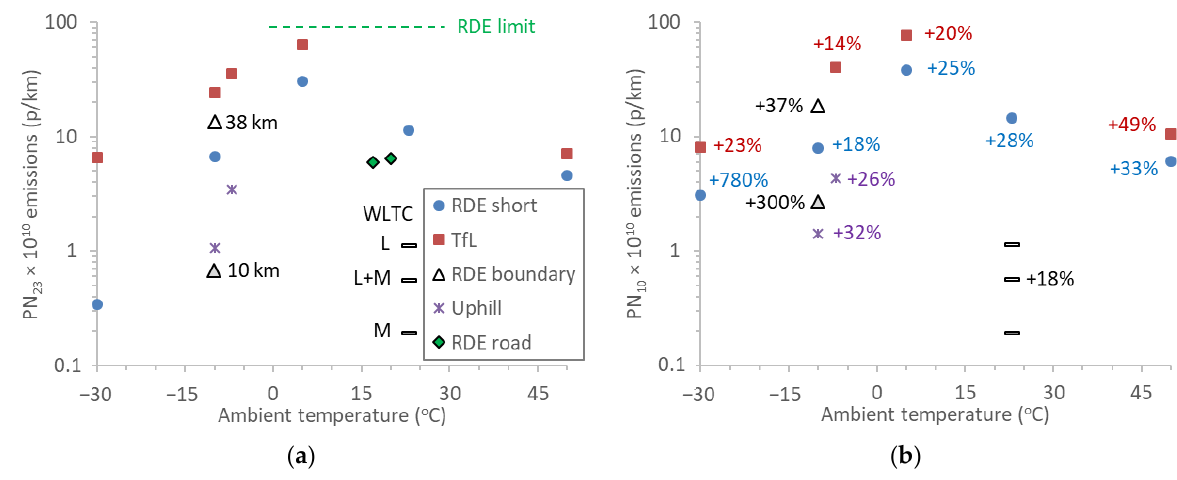
Figure 5. Particle number (PN) emissions of urban cycles (TfL, Uphill) or urban parts of the rest cycles (RDE short, RDE boundary, RDE road, WLTC) in function of ambient temperature. The emissions of the low (L) and medium (M) parts of the WLTC are also given. ( a ) PN > 23 nm; ( b ) PN > 10 nm. Percentages give the excess particles between 10 nm and 23 nm. RDE = real-driving emissions; WLTC = worldwide harmonized light vehicles test cycle.